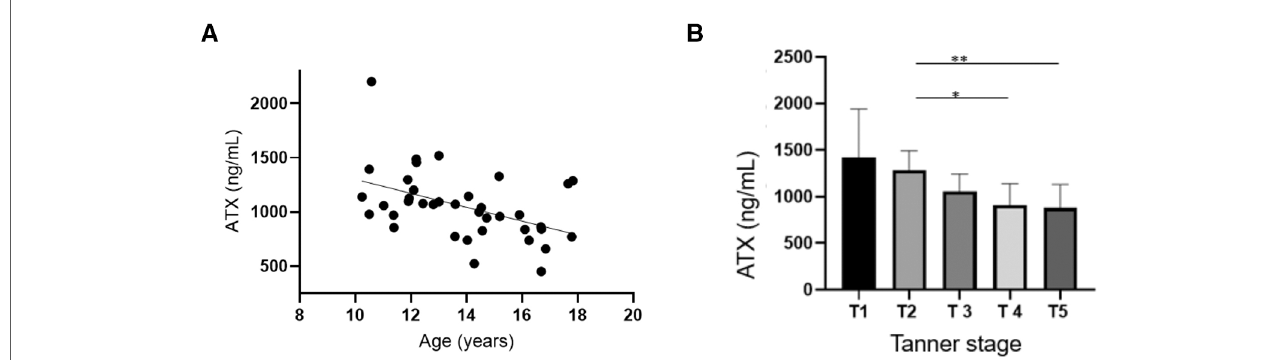
FIGURE 1 Autotaxin is negatively associated with age and pubertal status. ( A ) Correlation tests were conducted between ATX circulating levels (ng/ml) and age Spearman correlation test: r = − 0.47, IC95%= − 0.69 − ( − )0.16, p =0.0034 **. ( B ) Correlation tests were performed between ATX circulating levels (ng/ml) and the Tanner